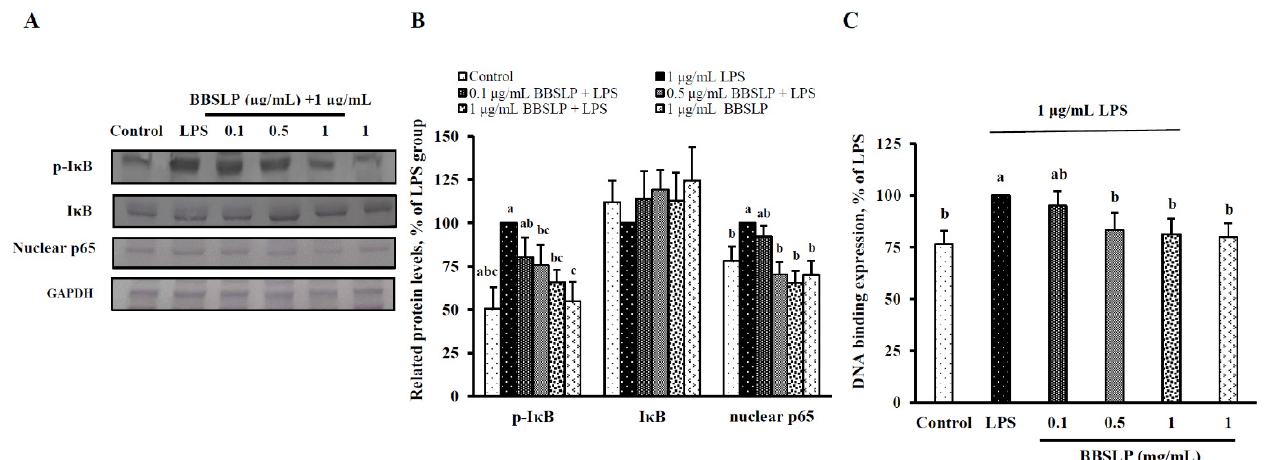
Figure 6. Effects of BBSLP on NF- κ B signalling activation in LPS-induced RAW264.7 cells. RAW264.7 cells (1 × 10 5 cells/30-mm plate) were seeded and cultured overnight, treated with 0.1, 0.5 or 1 µ g/mL BBSLP for 24 h and then induced or not with 1 µ g/mL LPS for another 24 h. The group treated with 1 µ g/mL LPS alone served as an induced control group. BBSLP was diluted in sterilized H 2 O, and cells treated with sterilized H 2 O alone served as the control group. Cells treated with 1 µ g/mL BBSLP without LPS treatment for 48 h were used as another control group. Phosphorylated I κ B (p-I κ B), I κ B and nuclear p65 expression ( A ), quantified p-I κ B, I κ B and nuclear p65 levels ( B ) and NF- κ B-DNA binding activity ( C ) were examined. Values are presented as means ± SD ( n = 3–5). abc Values are significantly different from the other groups as determined by Tukey’s test ( p < 0.05).